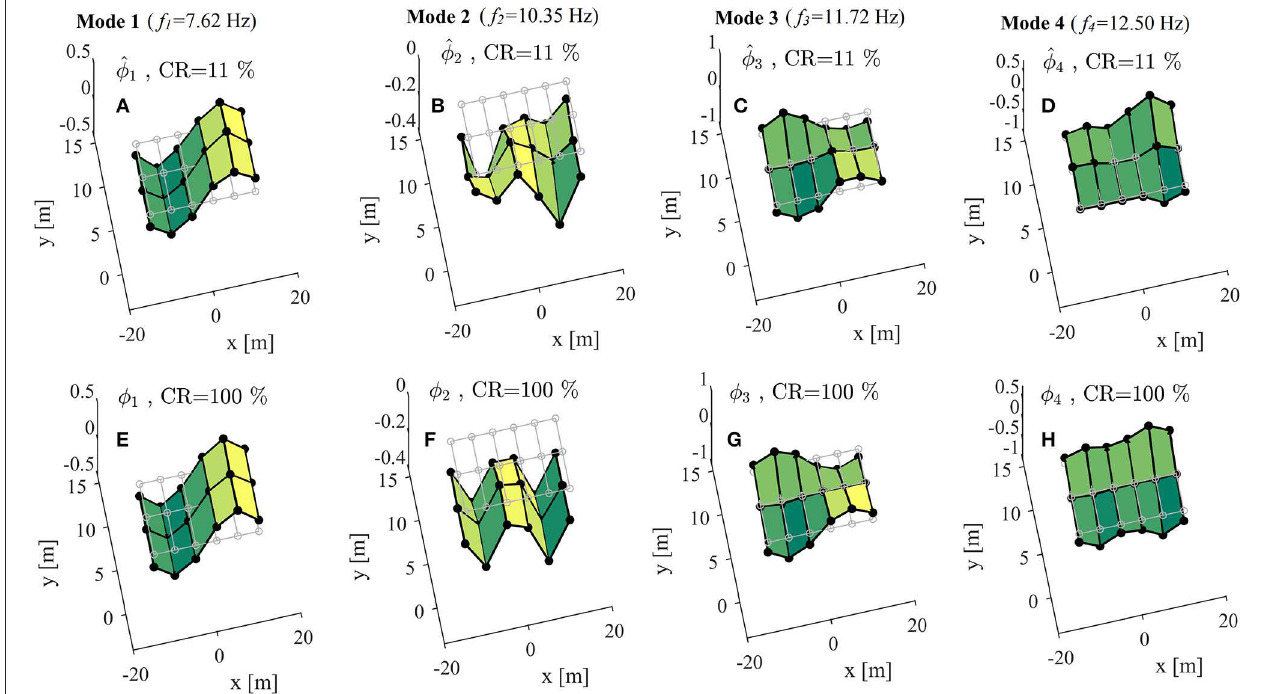
FIGURE 11 | Mode shapes of Bärenbohlstrasse overpass: (A–D) : estimated using the PSBS approach for CR application of FDD to the full-length recorded data.